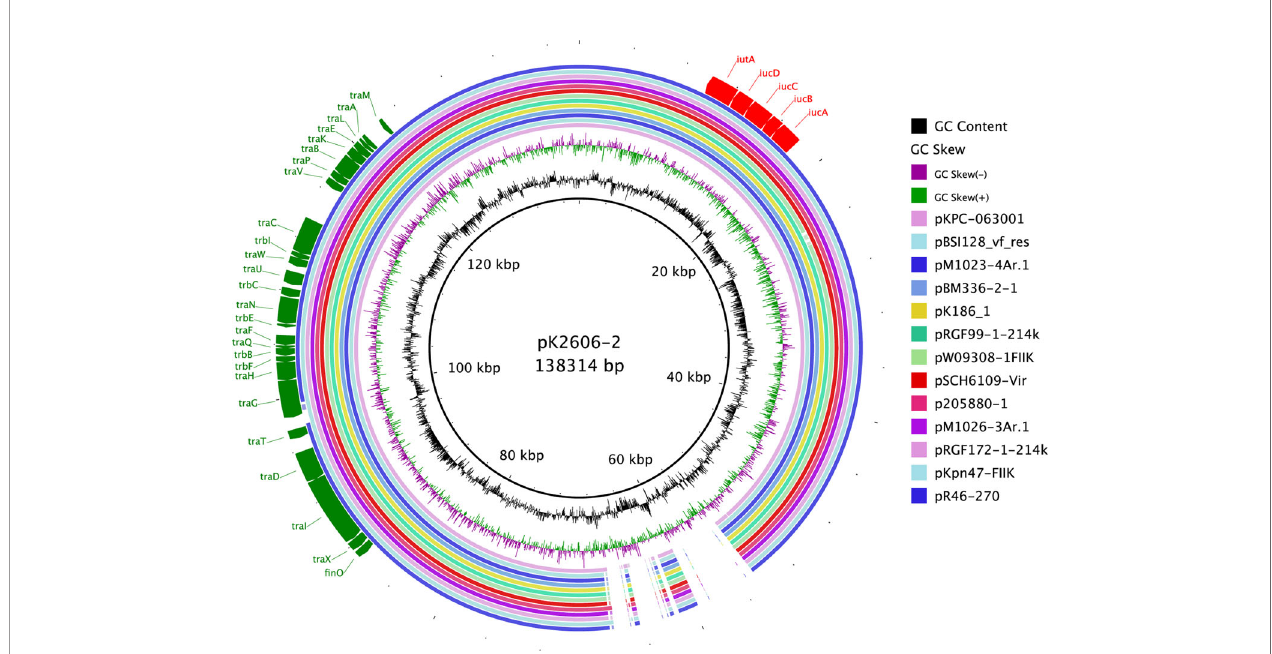
FIGURE 4 | Conjugative pK2606-like virulence plasmids of Klebsiella pneumoniae strains in GenBank. Circular maps were generated using BLAST Ring Image Generator (BRIG). pK2606 was used as a reference.